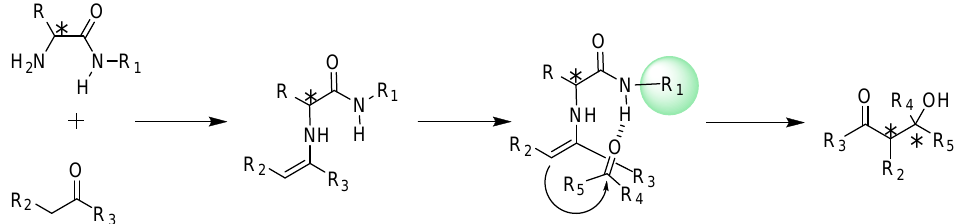
Scheme 3. Coordination of amino amide bifunctional catalysts in direct intermolecular aldol reac-